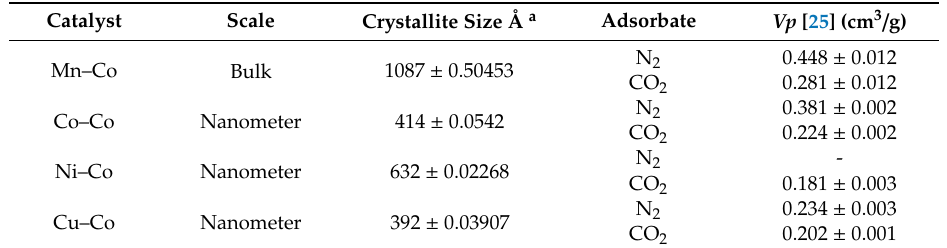
Table 2. Crystallite size according to the Scherrer equation and Vp , the pore volume estimate from N 2 and CO 2